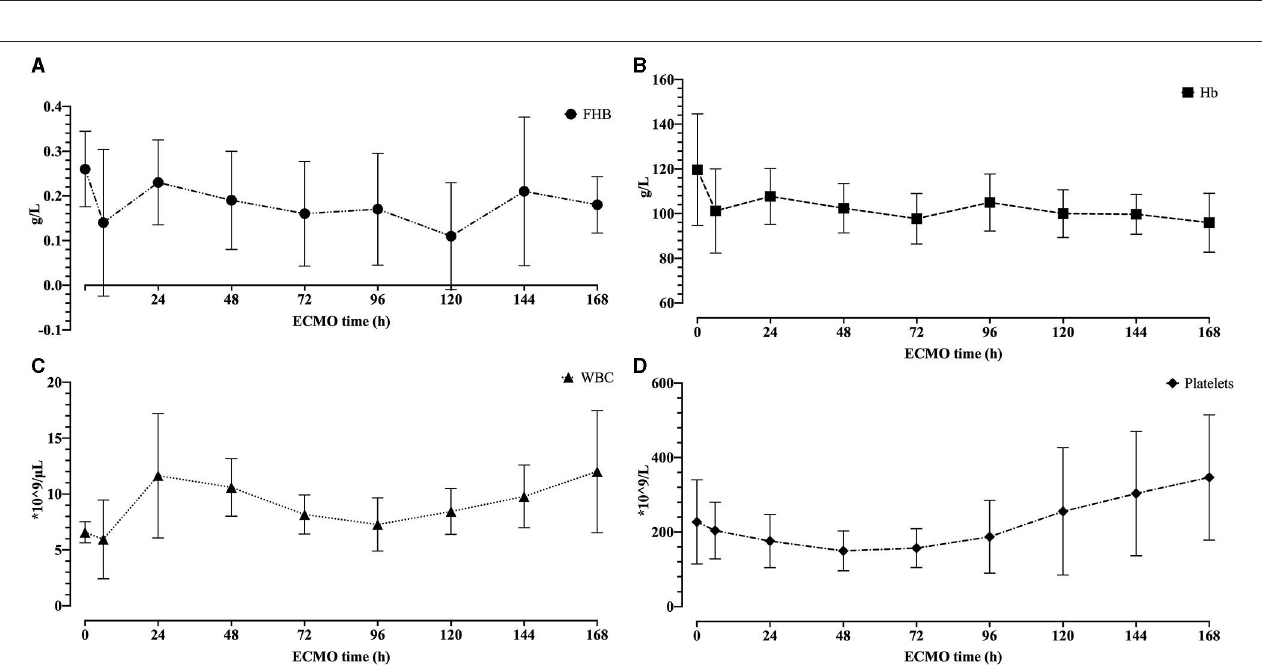
FIGURE 6 | The hemolytic blood damage results. (A) The free hemoglobin for 7 days. (B) The hemoglobin for 7 days. (C) The white blood cell for 7 days. (D) The platelets for 7 days.